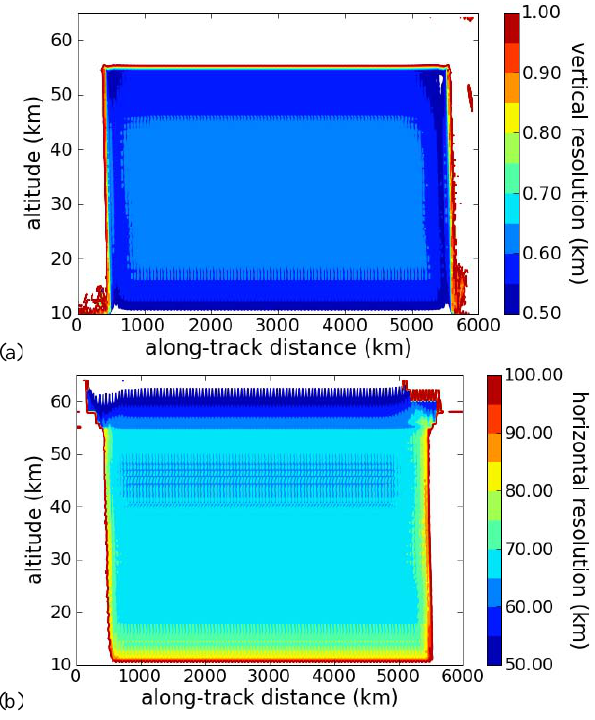
Fig. 8. Shown are the vertical (a) and horizontal (b) resolution for a baseline retrieval with no modulated wave structure (i.e. the at- mosphere of Fig. 5a). Tangent points of measurements lie between ≈ 10km and 55km vertically and ≈ 500km and 5500km horizon-